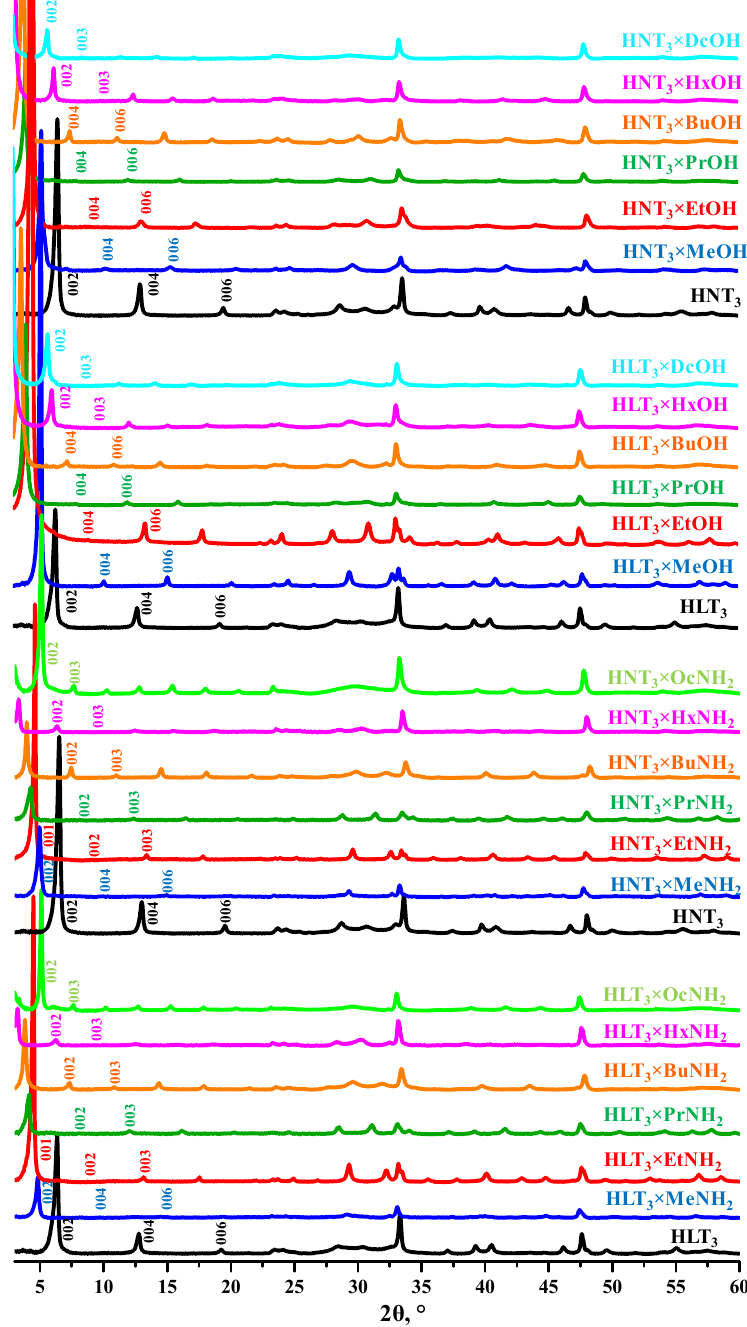
Figure 1. XRD patterns of the initial titanates and their inorganic-organic derivatives. Table 1. Structural parameters of the initial titanates and their inorganic-organic derivatives as well as tilt angles of organic chains.